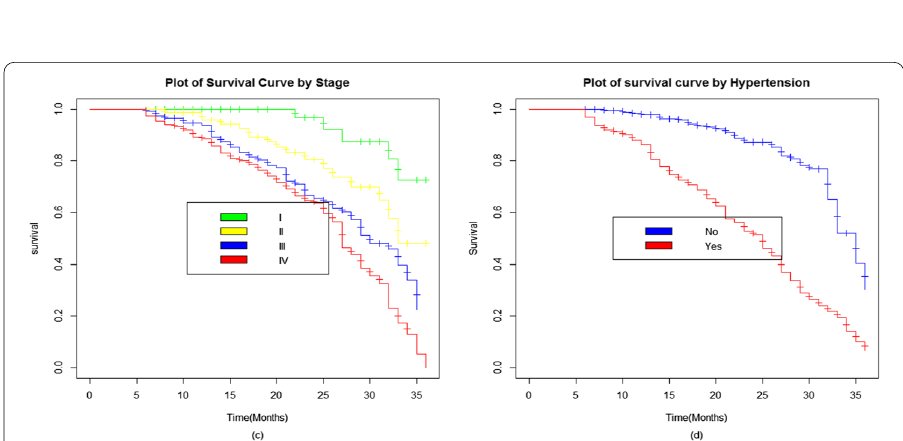
Fig. 2 Kaplan–Meier estimates of the survival curves of HF data set for ( c ) Stages, ( d )